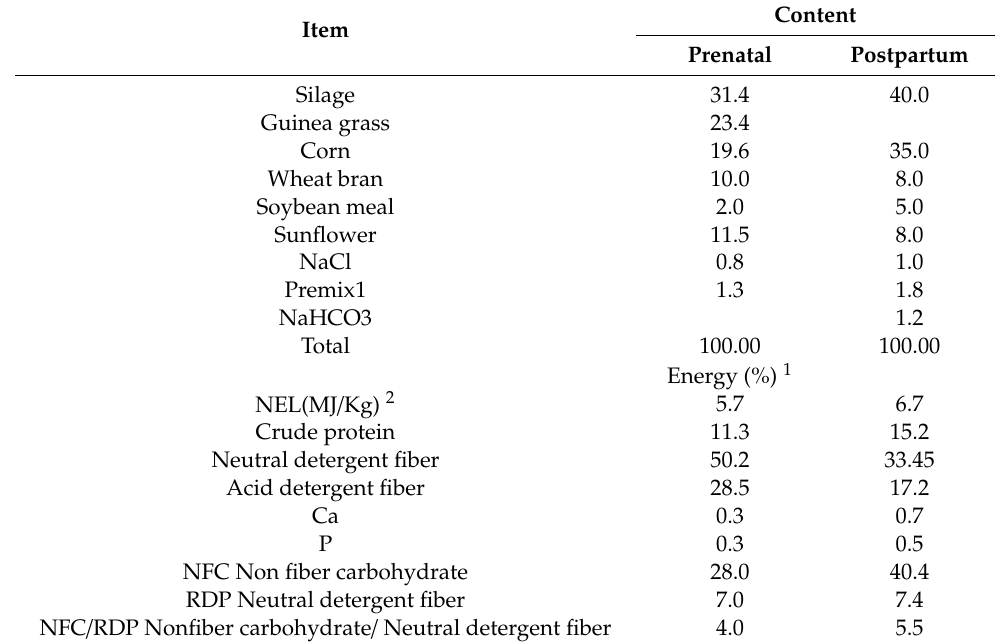
Table 2. The basic diet formulation,